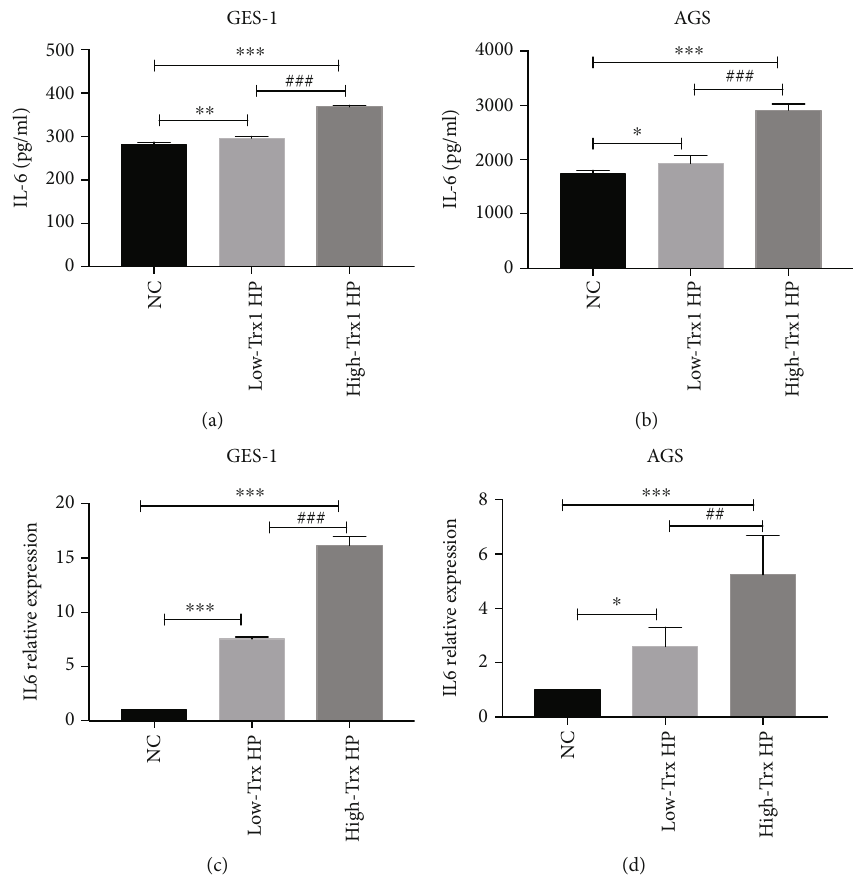
Figure 3: The high-Trx1 HP can cause higher expression of IL-6 in AGS and GES-1 cells. (a, b) The IL-6 expression of GES-1 and AGS cells during low-Trx1 HP and high-Trx1 HP infection were analyzed by ELISA test. (c, d) The IL-6 expression of GES-1 and AGS cells during low-Trx1 HP and high-Trx1 HP infection was analyzed by real-time PCR test. Note: NC means uninfected control group, low-Trx1 HP means HP with low Trx1 expression, and high-Trx1 HP means HP with high Trx1 expression, ∗ P < 0 : 05 , ∗∗ P < 0 : 01 , ∗∗∗ P < 0 : 001 , ## P < 0 : 01 , and ### P < 0 : 001